Question: Give a one-sentence summary of this figure.
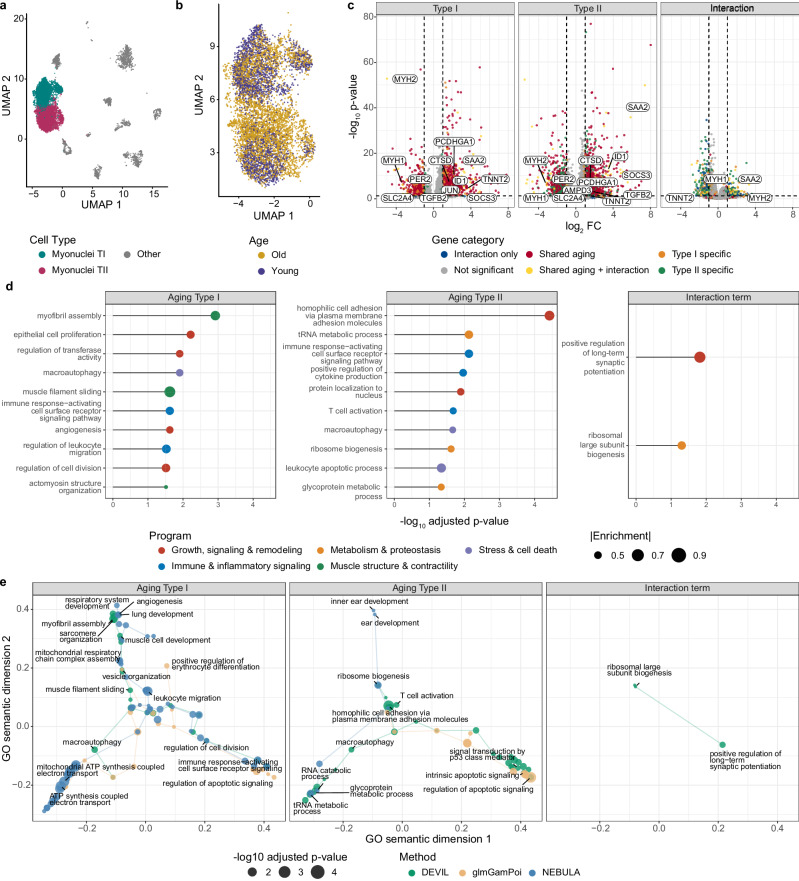
Answer: Aging-associated transcriptional programs in human skeletal muscle myonuclei. a , b UMAP embedding of the snRNA-seq dataset from human limb skeletal muscle, colored by myonuclei subtype (Type I, Type II, other; a ) or age group (young vs. old; b ). c Volcano plots showing differential expression results obtained with DEVIL for aging contrasts in Type I myonuclei, Type II myonuclei, and the age-by-myofiber subtype interaction. Genes are colored by category, and selected biologically relevant markers are annotated. d Top enriched Gene Ontology biological process terms identified by DEVIL for each contrast. Dot position indicates significance, dot size reflects enrichment magnitude, and colors denote broad biological program categories. e Two-dimensional GO semantic similarity maps summarizing enriched pathways across contrasts and methods. Each point represents a GO term positioned by semantic similarity, with point size indicating statistical significance. Adjusted P values were obtained from Gene Set Enrichment Analysis (GSEA; permutation-based test with 50,000 permutations) and corrected for multiple comparisons using the Benjamini–Hochberg (BH) procedure. Source data are provided as a Source Data file.